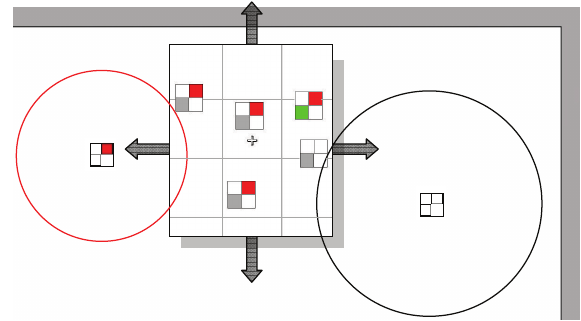
Figure 2: Panning a dynamic peephole window over a large fixed workspace. Only the part in the peephole window is visible at a time.